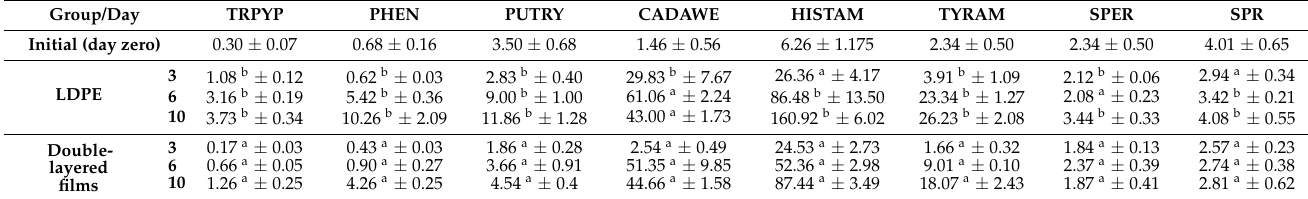
Table 3. Biogenic amine concentration in fish samples through storage in 4 ◦ C